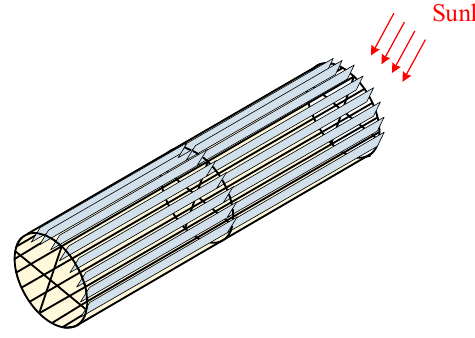
Figure 10. Illustration of the control strategy.